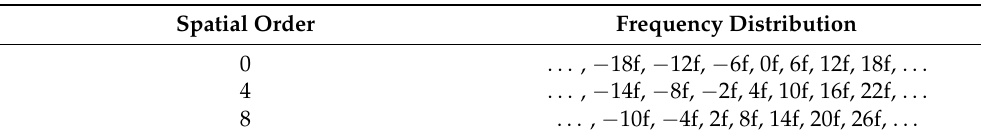
Table 9. Frequency distribution of low-order radial force harmonics of 8-pole, 12-slot, permanent- magnet motor.